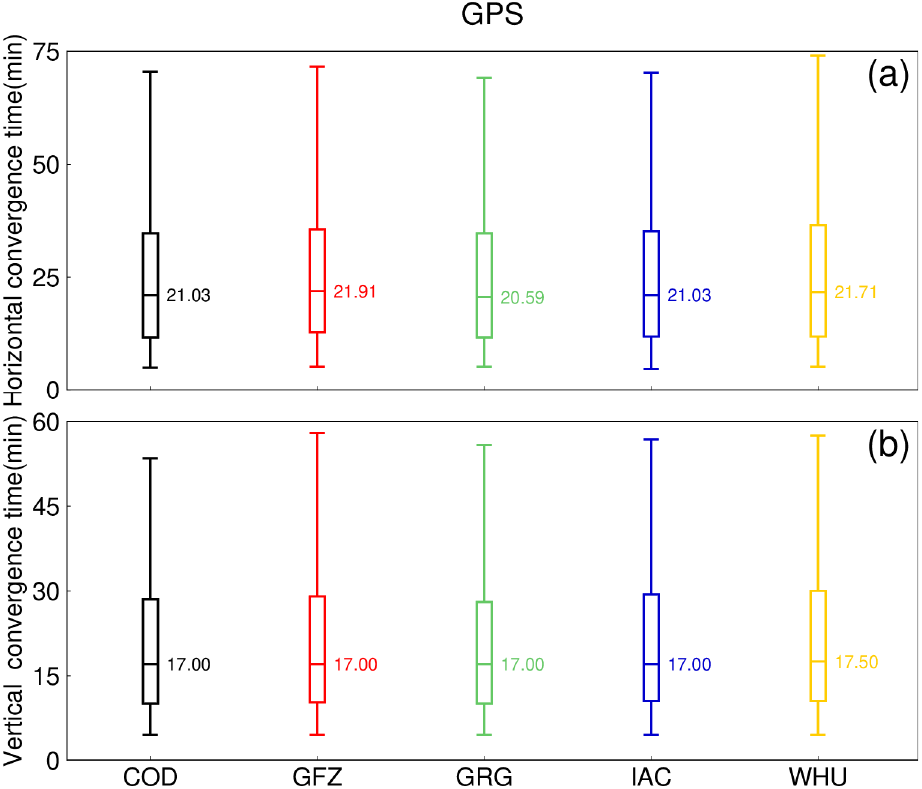
Figure 13. Distribution of the convergence time of the GPS kinematic PPP solutions with five types of precise products for the 143 MGEX tracking stations in September 2022. ( a ) Horizontal component, ( b ) Vertical component.